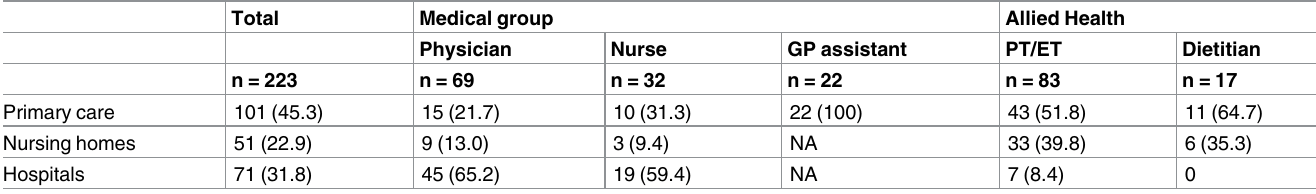
Table 1. Current occupation and working affiliation of attending healthcare professionals (n =